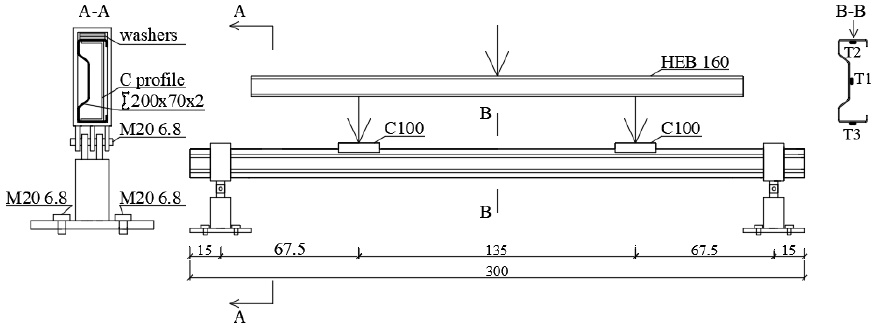
Figure 2. Laboratory stand scheme and location of measurement points.